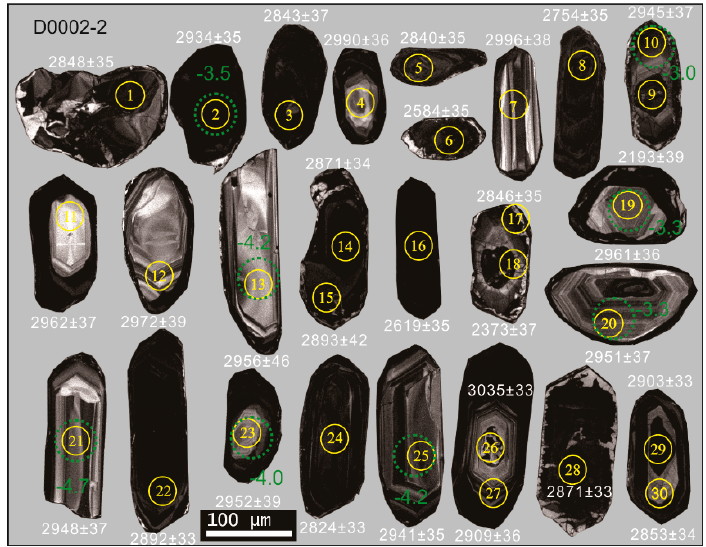
Figure 6. Representative cathodoluminescence images of zircons from the tonalitic gneiss (D0002-2). Symbols are as in Figure 4.